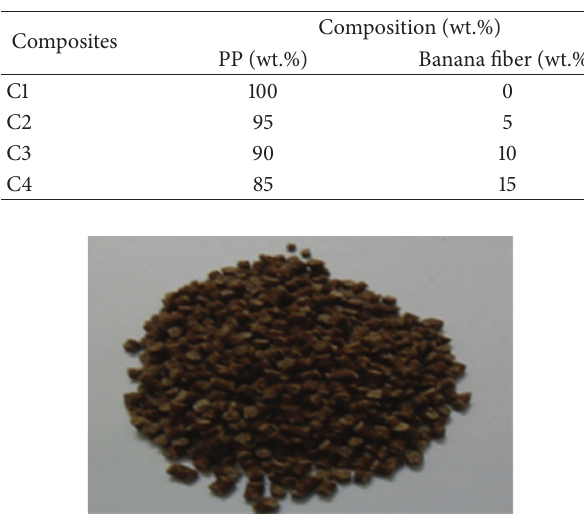
Figure 1: Pellets of BBF/PP composites.